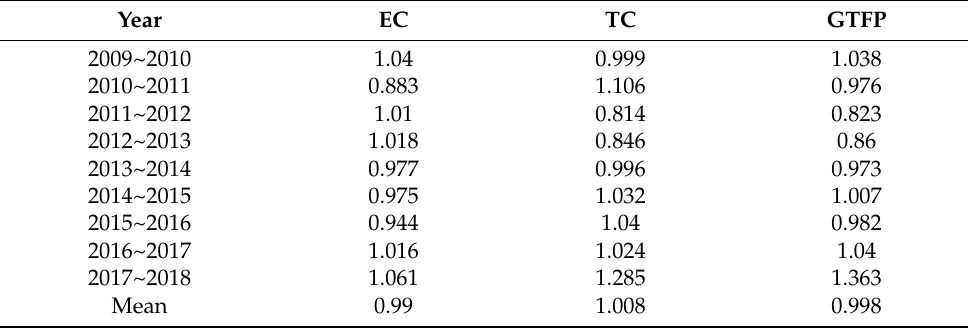
Table 2. GTFP and its decomposition in the YREB from 2009 to